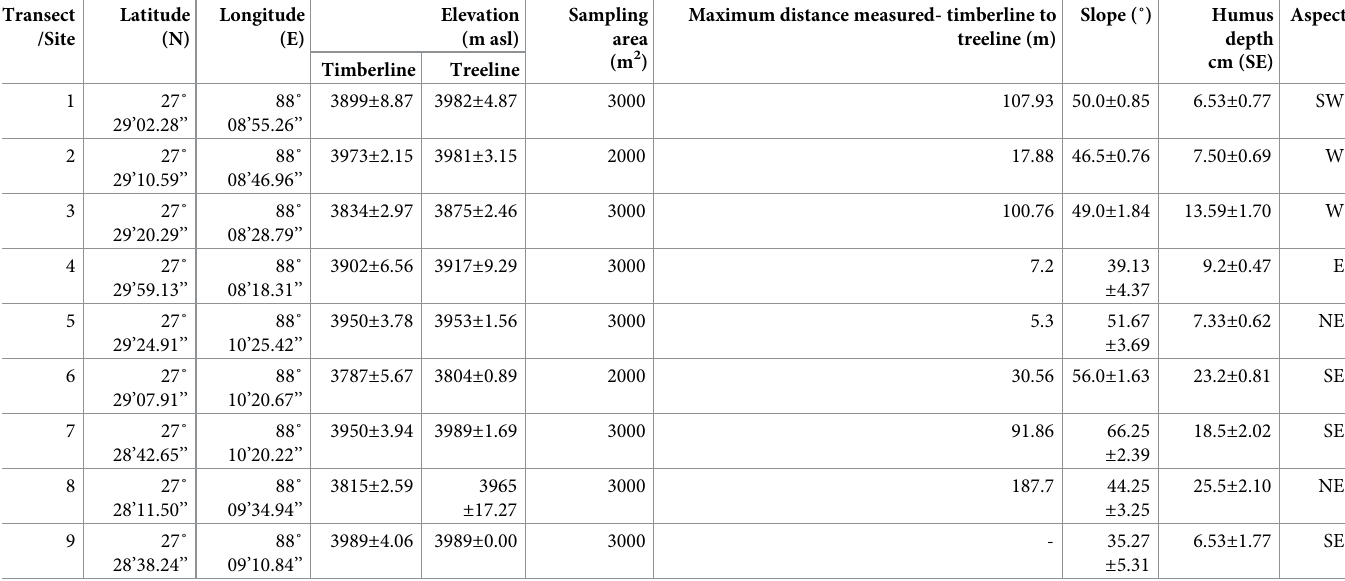
Table 1. Site characteristics of timberlines in Khangchendzonga National